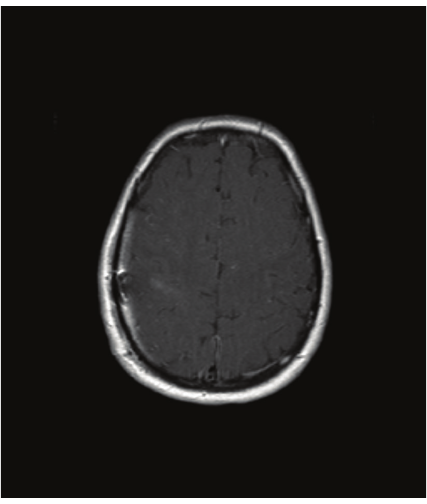
Figure 7: Postoperative MRI showing that the tumor has been totally